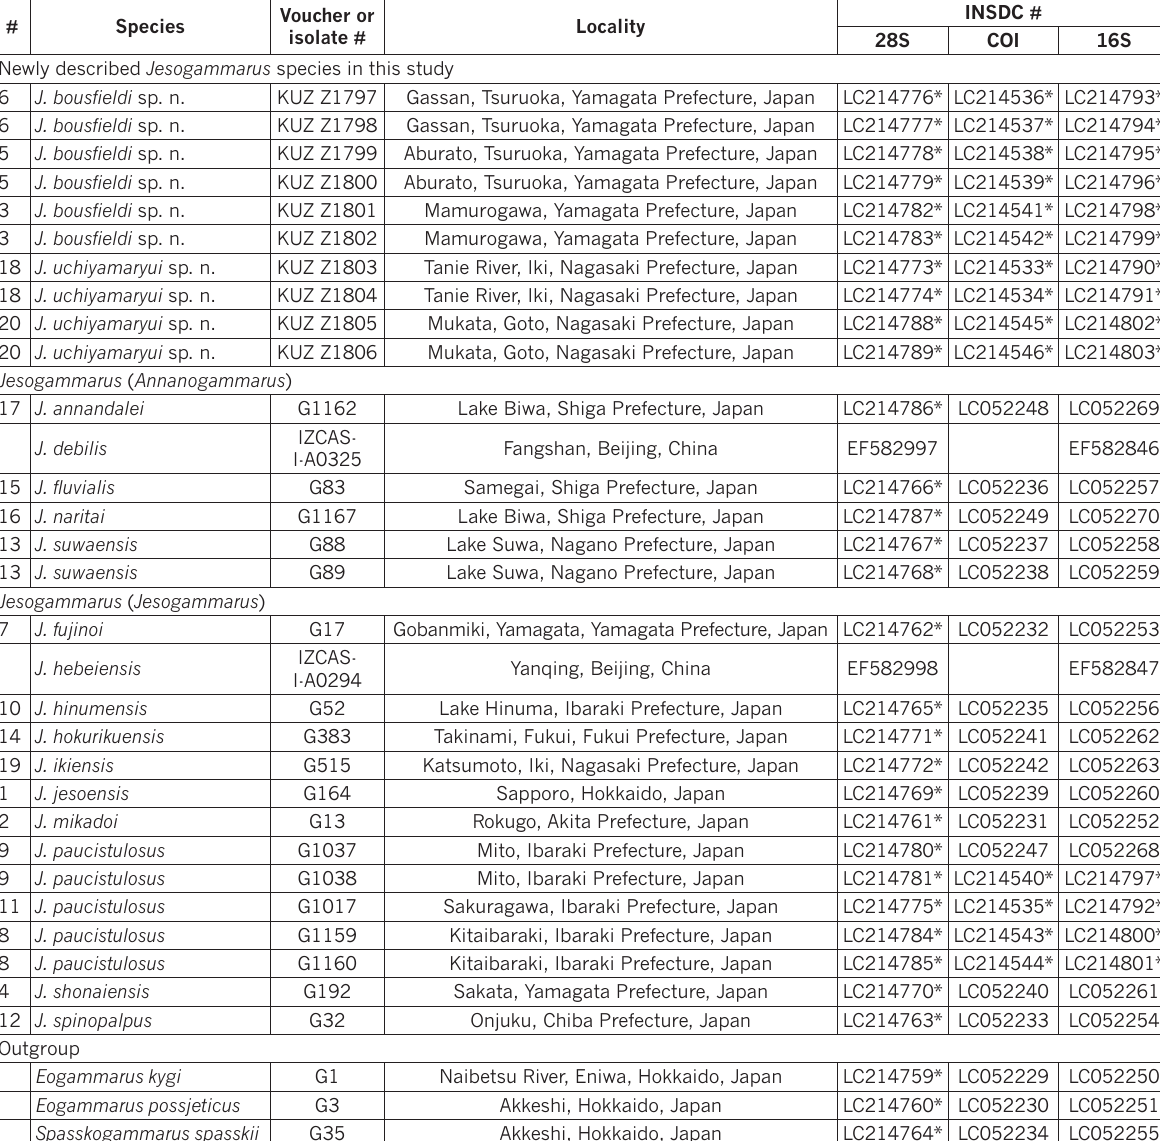
Table 1. Samples used for the phylogenetic analyses. The information on the vouchers or isolate numbers is accompanied by the collection localities and the INSDC accession numbers. Sequences marked with an asterisk were obtained for the first time in the present